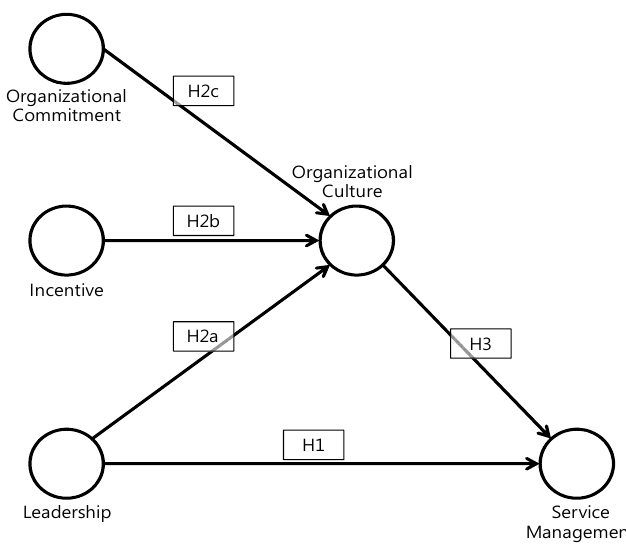
Figure 3. The hypothesis model.